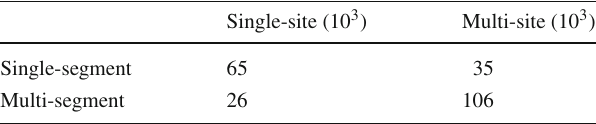
Fig. 8 SS event recognition and MS event rejection efficiencies as a function of the discrimination threshold on the classifier output for the DEP (mostly SS) and the FEP (mostly MS). Inside the highlighted areas, more events are accepted or rejected than the peak contains of the associated class Table3 Classificationsbytheneuralnetwork(discriminationthreshold of 0.6) of single-segment and multi-segment